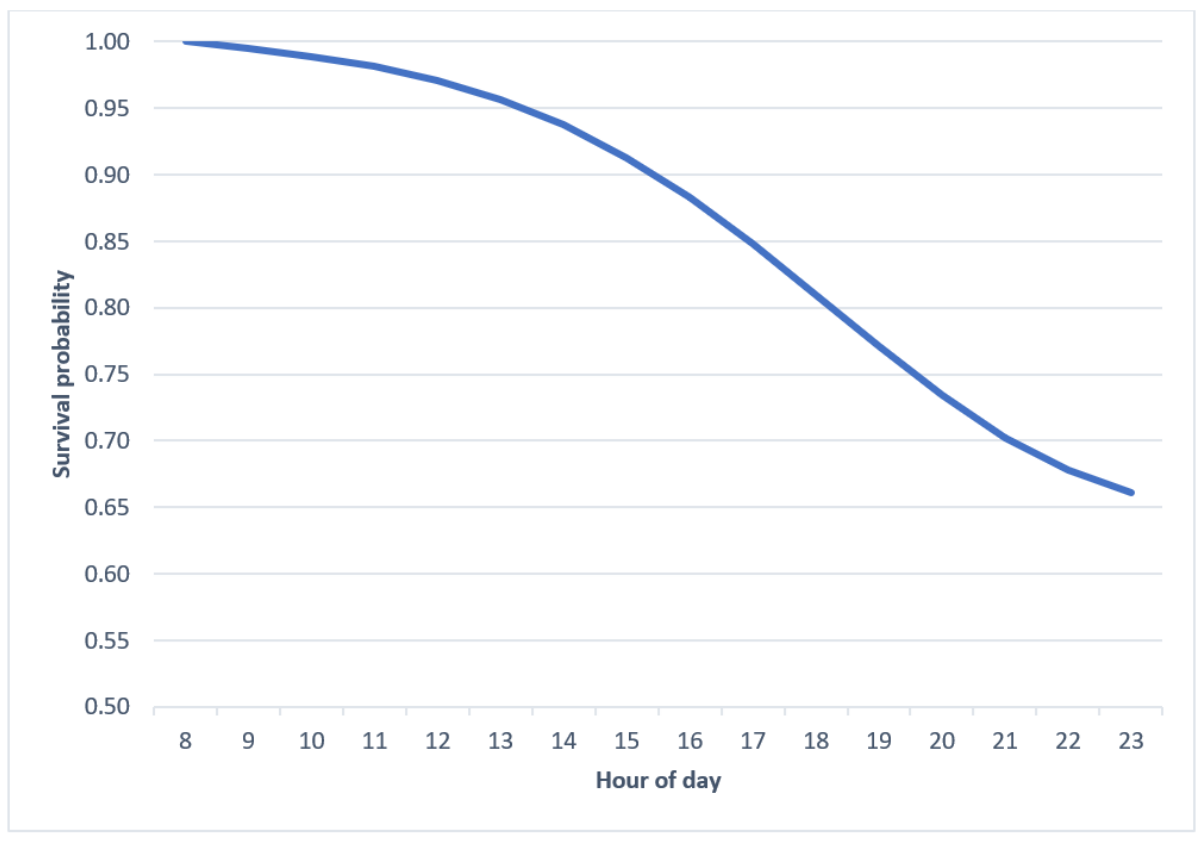
Figure 6. Survival probabilities of obtaining average moderate-to-vigorous physical activity before each hour of